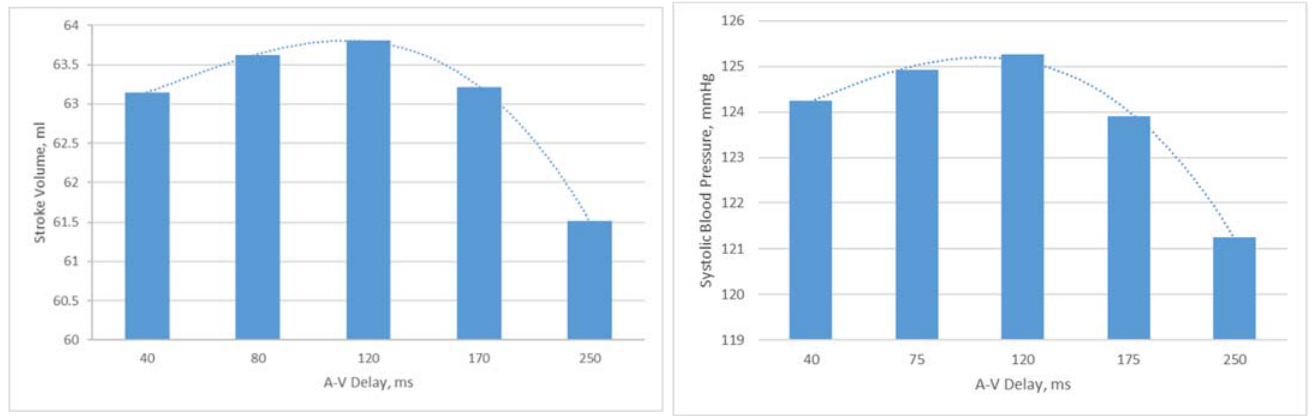
Figure 7. ( Left ) Stroke volume vs. AV delay predicted by LHHM with heart rate of 90 bpm, ( Right ) systolic blood pressure vs. AV delay predicted by LHHM with heart rate of 90 bpm.